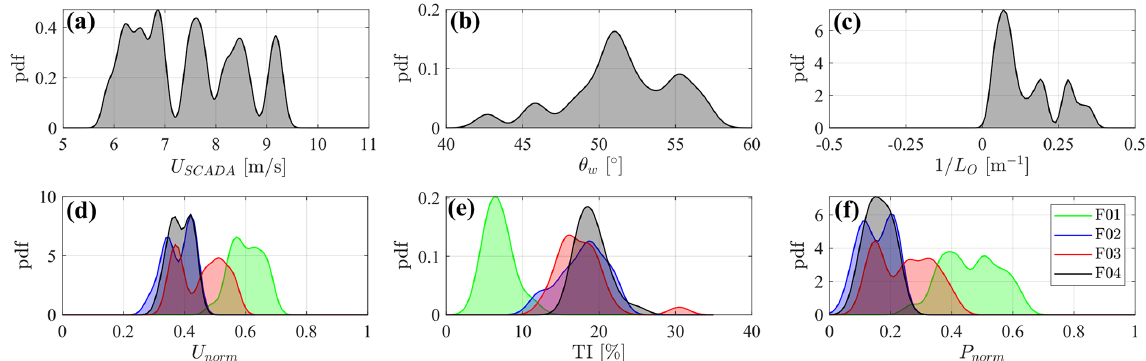
Figure 15. Probability density functions of met and SCADA data recorded from 21:00 to 01:00MDT in the night between 5 and 6 September 2018. (a) Wind speed from met towers. (b) Wind direction from met towers. (c) Inverse Obukhov length from our sonic anemometers. (d) Normalized wind speed from SCADA. (e) Turbulence intensity from SCADA. (f) Normalized power from SCADA.